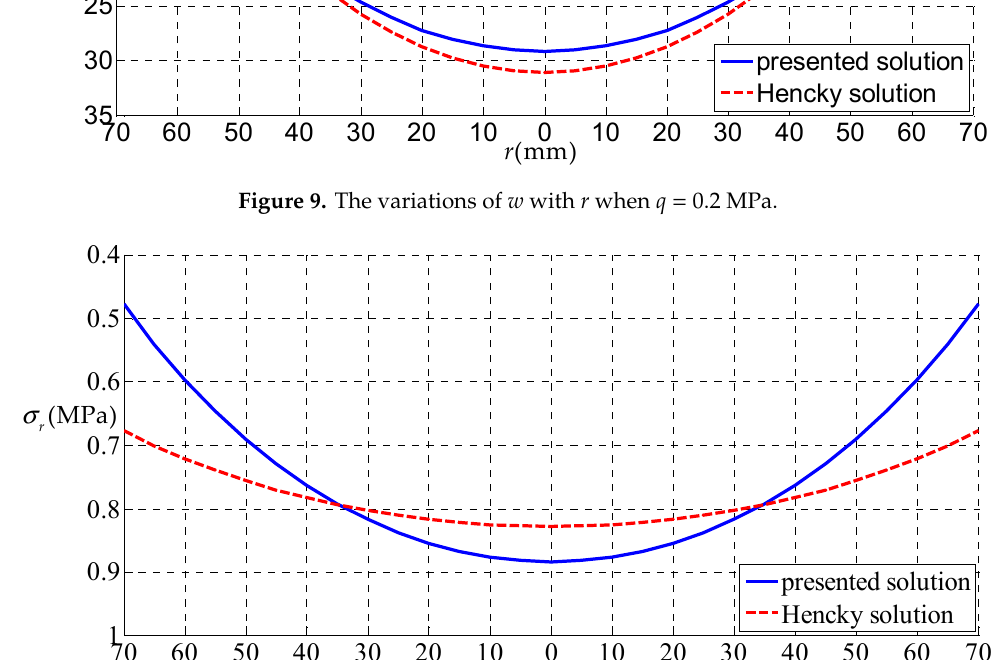
σ with r when q = 0.07MPa. Figure 10. The variations of Figure 10. The variations of σ r with r when q = 0.07MPa. r